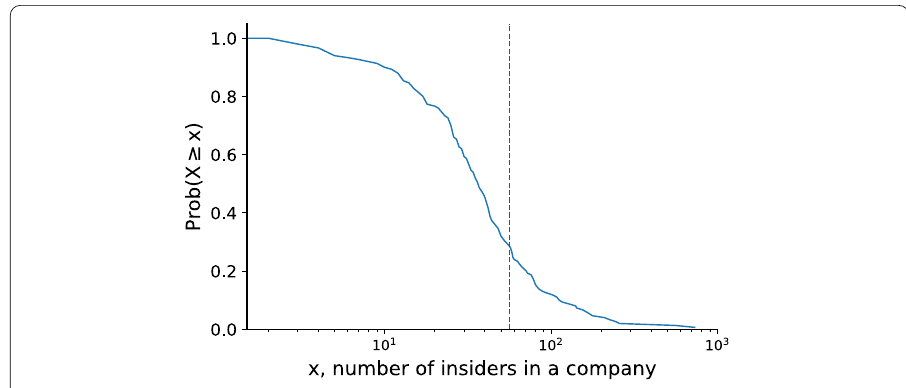
Figure 14 Complementary cumulative distribution function for the numbers of insiders in a company. Number of insiders ranges from 2 to 729 per company. The number of companies is 150. Red dashed line marks the average number of insiders per company = 56.25 ( ± 82.89), the mode = 25, and the median = 36